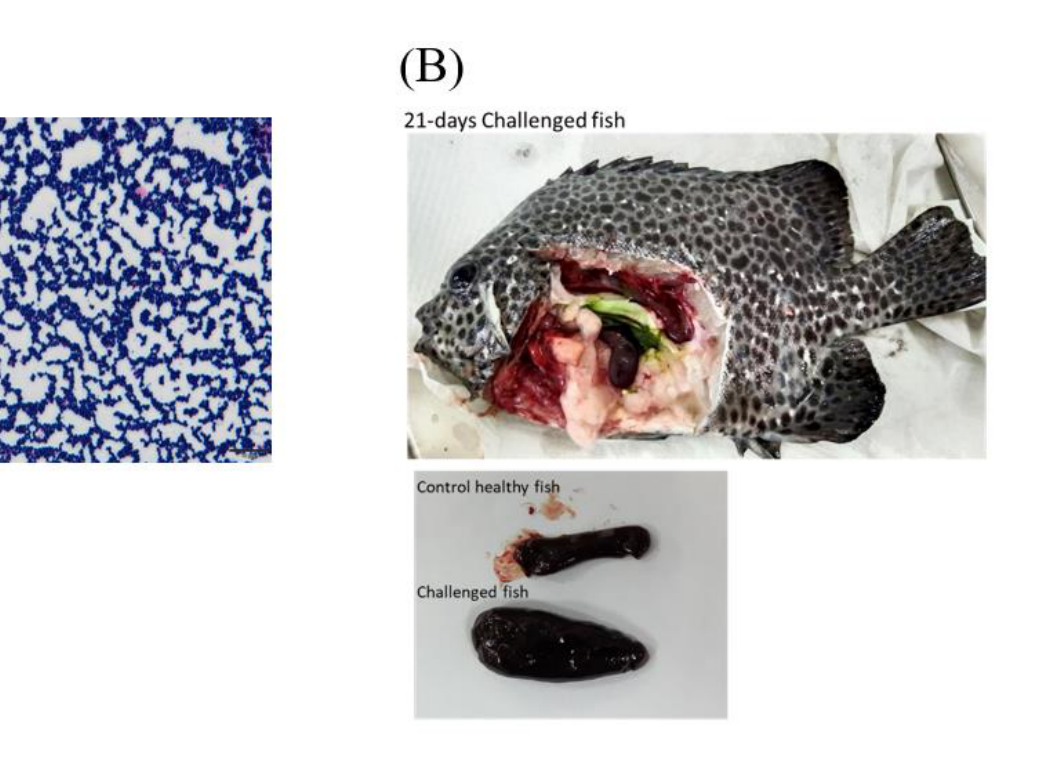
Figure 3. ( A ) Results of Gram staining for Enterococcus gallinarum isolated from moribund Oplegnathus punctatus . ( B ) O. punctatus intraperitoneally injected with E. gallinarum showed spleen enlargement 21 days post injection (dpi).